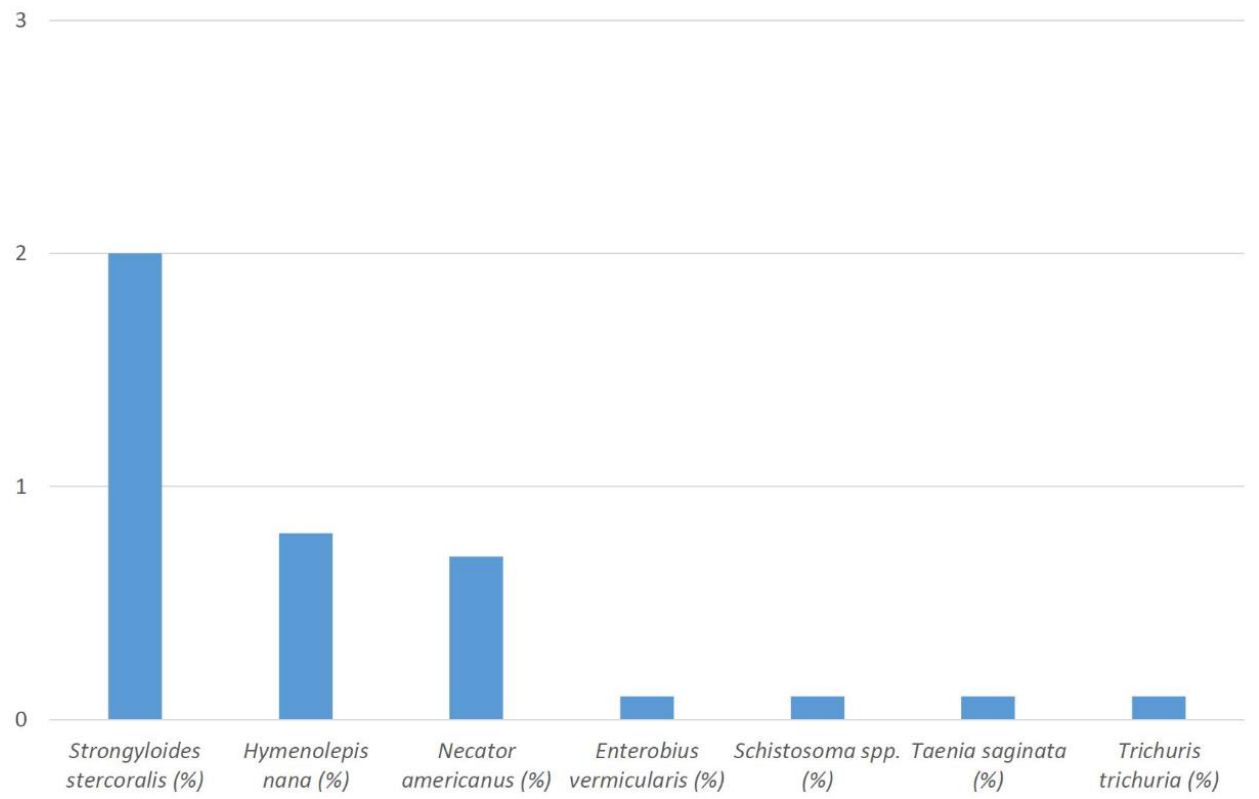
Figure 1. Percentages (%) of recorded helminth DNA in the stool samples of the study participants. Table 1. Positive PCR results and recorded cycle threshold (Ct) value ranges. A total of 2046 samples were assessed.